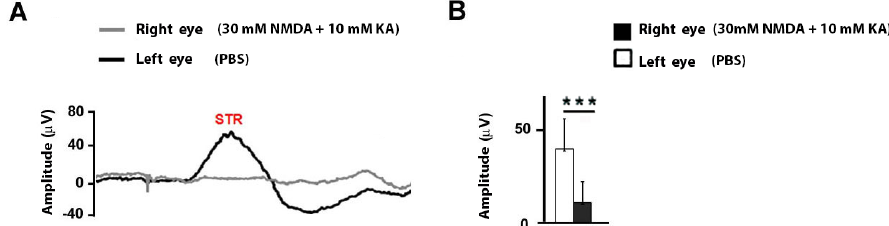
Figure 3. Amplitude of the STR wave after intraocular injection of NMDA and Kainate. A, Electroretinographic records of the STR wave obtained in the right eye injected with 30 mM NMDA and 10 mM KA (gray trace) and left eye injected with PBS (black trace) in response to − 4,5 log cd·s/m 2 . B, Comparison of the STR wave amplitude between both eyes. The values shown in B correspond to the mean and the standard deviation, n = 11.